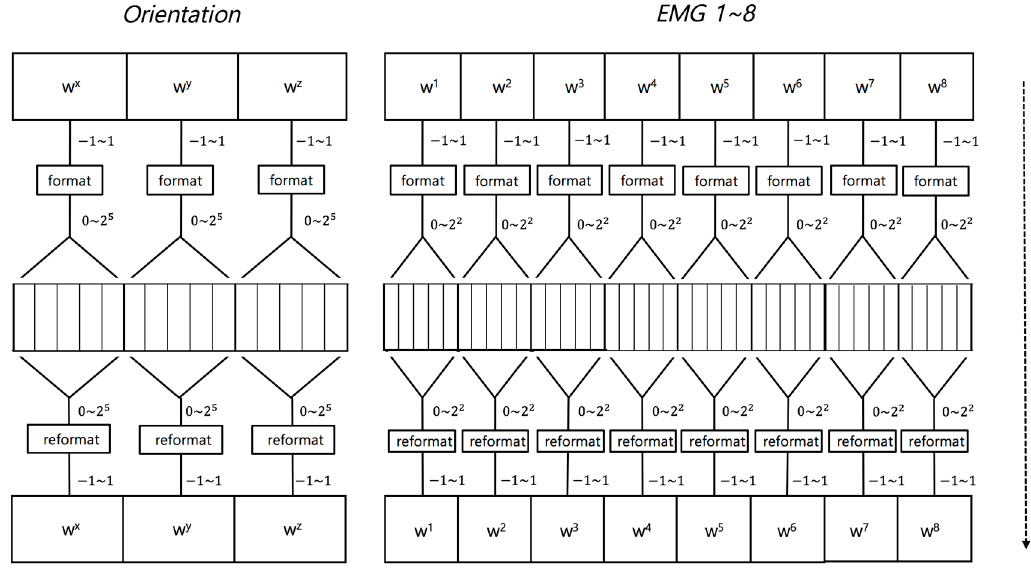
Figure 5. Data structure of the genetic algorithms.